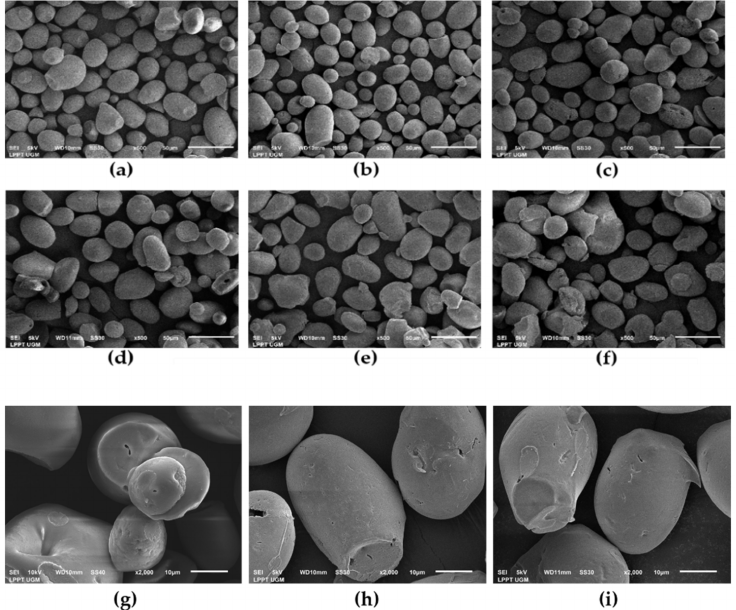
Figure 5. Scanning electron microscopy (SEM) images of native, HMT, and OSA starch samples. ( a ) = native starch; ( b ) = HMT 10; ( c ) = HMT 15; ( d ) HMT 20; ( e ) = HMT 25; ( f ) = HMT 30 at magnification images of 500 × ; ( g ) = HMT25; ( h ) = Native-OSA starch; and ( i ) = HMT25-OSA at magnification images of 2000 ×